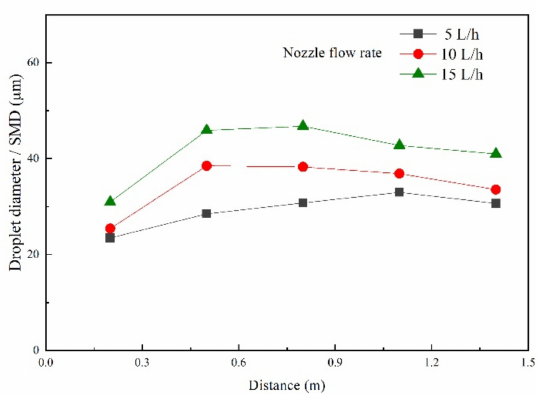
Figure 7. The droplet particle size with different spray nozzle flow rate.